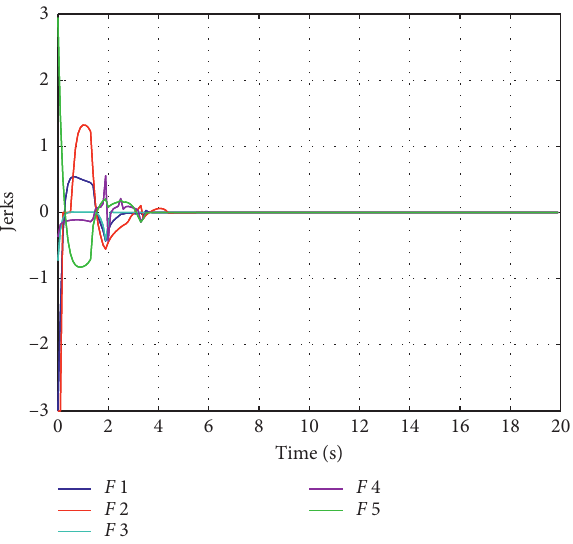
Figure 5: Jerks of the vehicles. Figure 6: Control inputs u